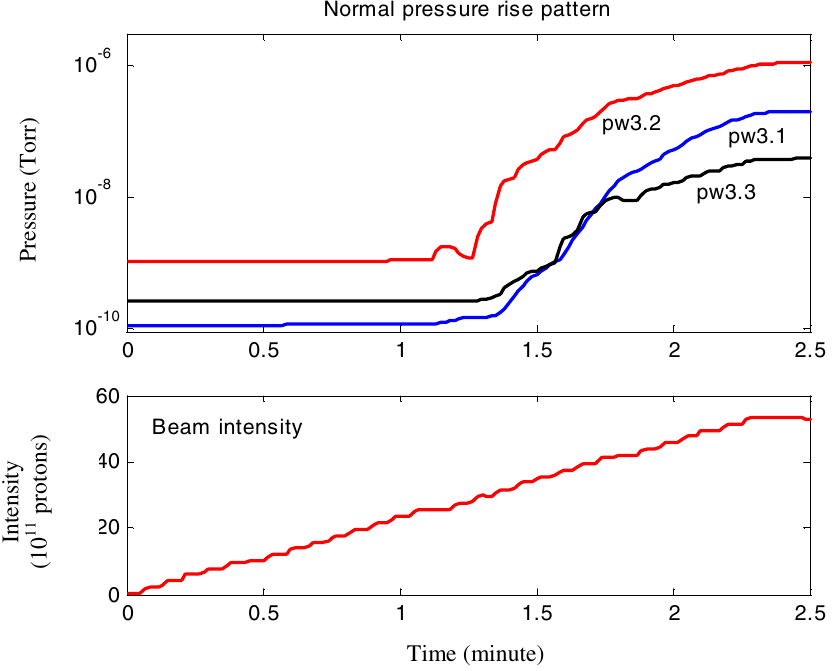
FIG. 8. (Color) Normal pressure rise pattern during injection in single beam straight sections without ridges or NEG coating. The pressure rise is the highest at pw3.2, which is at the middle of the straight section, and about an order of magnitude lower at pw3.1 and pw3.3, which are at the ends of section. With similar pumping capacity of ion pumps close to each vacuum gauge, the ones at pw3.1 and pw3.3 are assisted by cryogenic pumping from the cold bore. In addition, the electron multipacting at the middle of straight sections is suspected to be